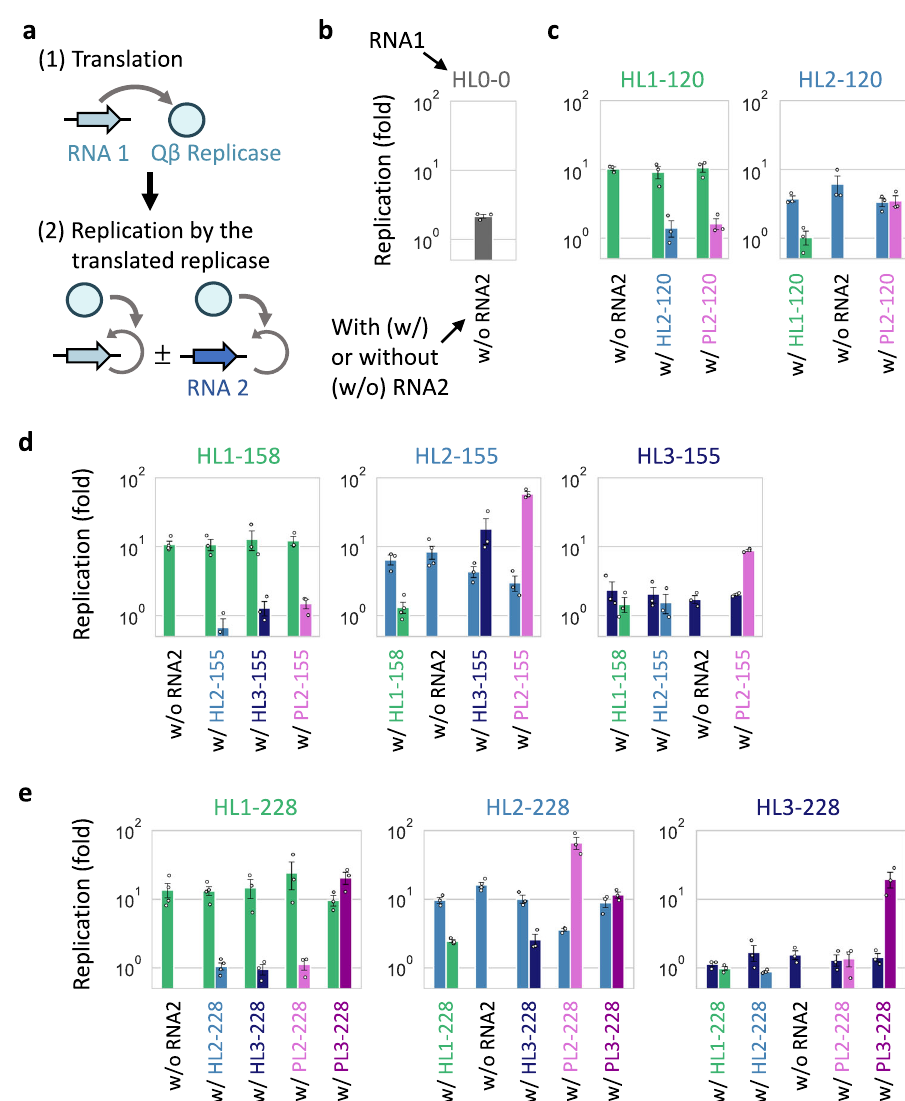
Fig. 4 Translation-uncoupled replication experiments. a The experiments were performed in two steps. (1) First, one of the host RNA clones (RNA 1, 30 nM) was incubated at 37 °C for 2 h to translate the replicase without RNA replication. (2) The reaction mixture was diluted, and RNA replication was initiated with the translated replicase at 37 °C for 2 h while stopping translation, in the presence or absence of the same concentration (10 nM) of another RNA clone (RNA 2). The replication of each RNA was measured by sequence-speci fi c RT-qPCR. b – e Replication of one or pairs of RNA clones at rounds 0 ( b ), 120 ( c ), 155 – 158 ( d ), and 228 ( e ). Colors match those in Fig. 3d. Error bars indicate mean ± SEM ( n = 3 or 4 as shown as individual data points). Measurements were taken from distinct samples. Average fold replications (>1.5-fold) were used to draw the directed graphs (Fig. 3d). Source data are provided as a Source data fi